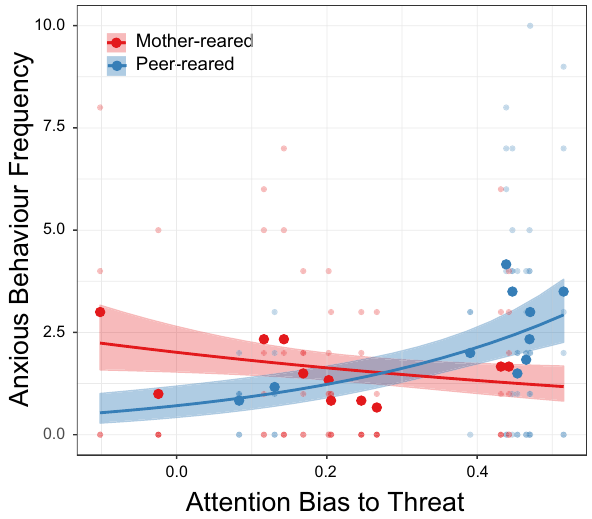
Figure 3. The relation between attention bias to threat (ABT) and frequency of anxiety-like behaviour in the mother-reared (red) and peer-reared (blue) group. Each light-coloured dot represents an individual behavioural observation session, large dark-coloured dots represent the subject mean, dark lines indicate the model fit, and shaded regions around the lines denote + or − SE.